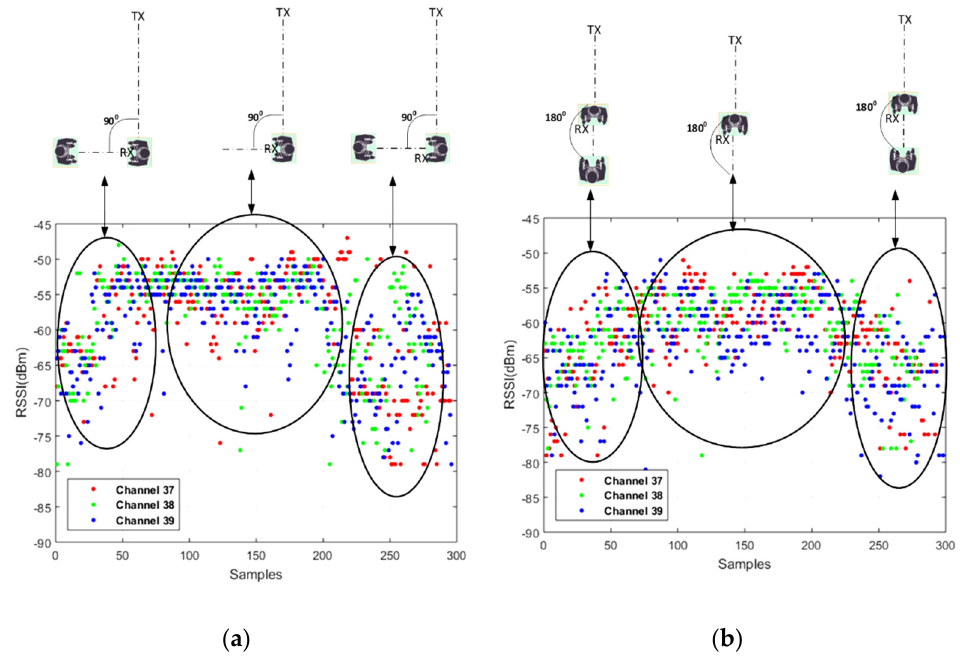
Figure 12. RSSI samples received from the three advertising channels in receiver facing ( a ) 90° and ( b ) 180° rotation from the transmitter. Table 2. Mean and standard deviation values of RSSI with and without the shadowing effect. Angle